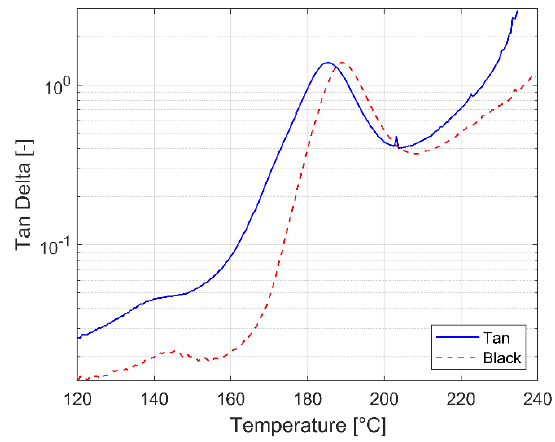
Figure 3. Tanδ versus temperature for ULTEM TM 9085 tan and black.